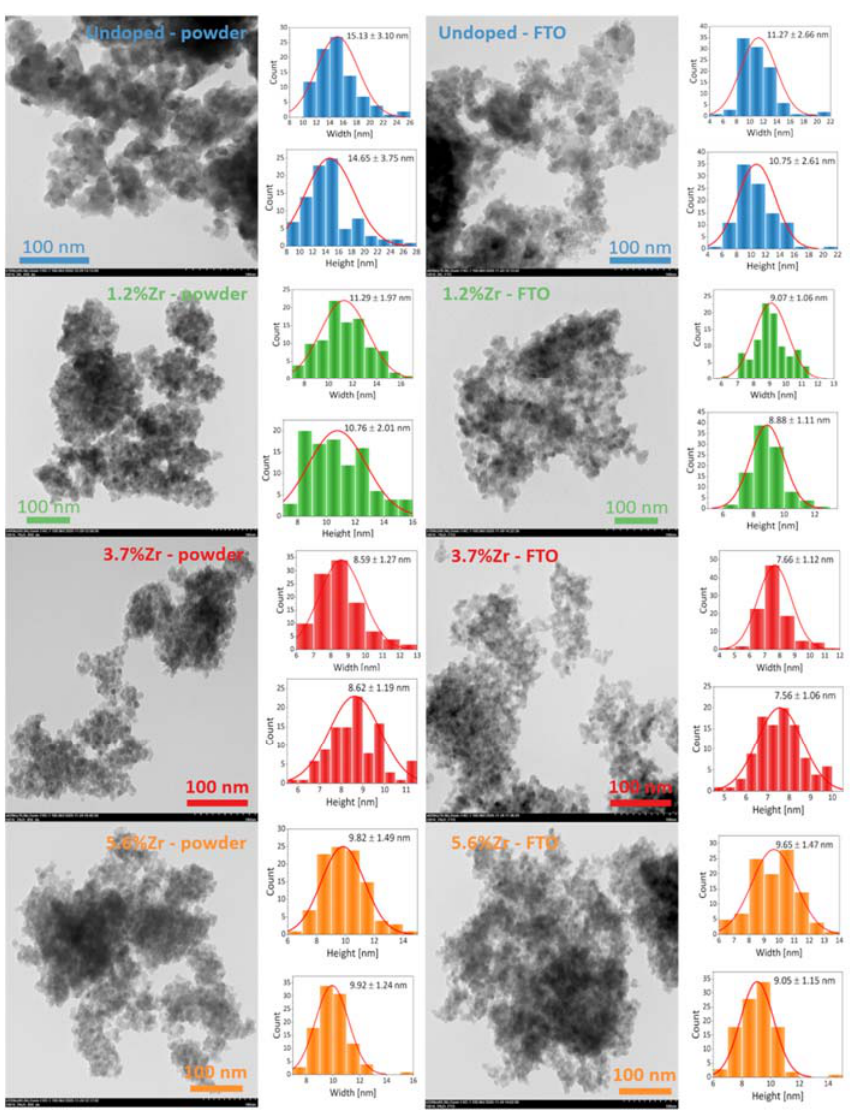
Figure 6. TEM images of undoped TiO 2 and Zr ‐ doped nanopowders with distribution histograms annealed at 450 °C for 2h ( left column ), and FTO nanoparticles ( right column ).